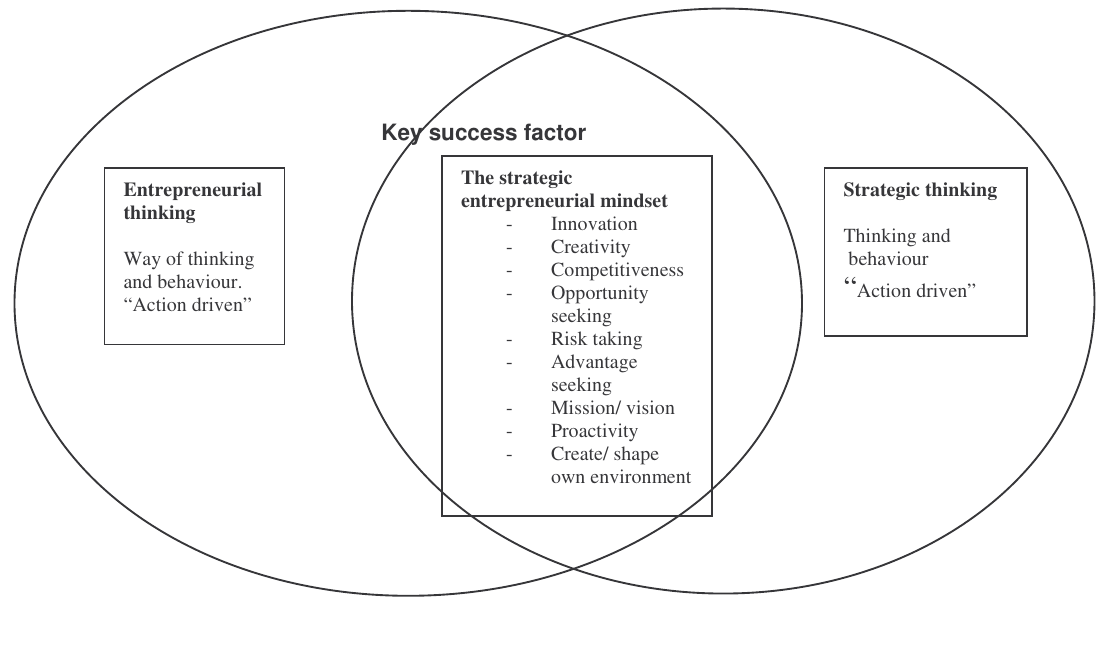
Figure 1: The strategic entrepreneurial mindset model